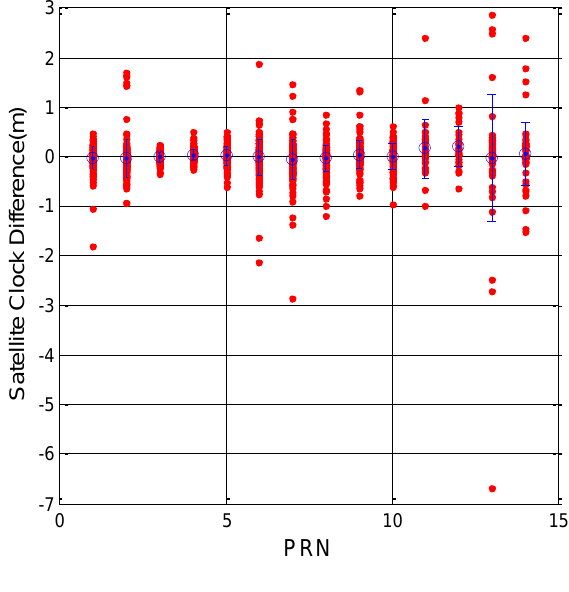
Figure 9. BDS DQA2: Satellite clock correction difference between new and original